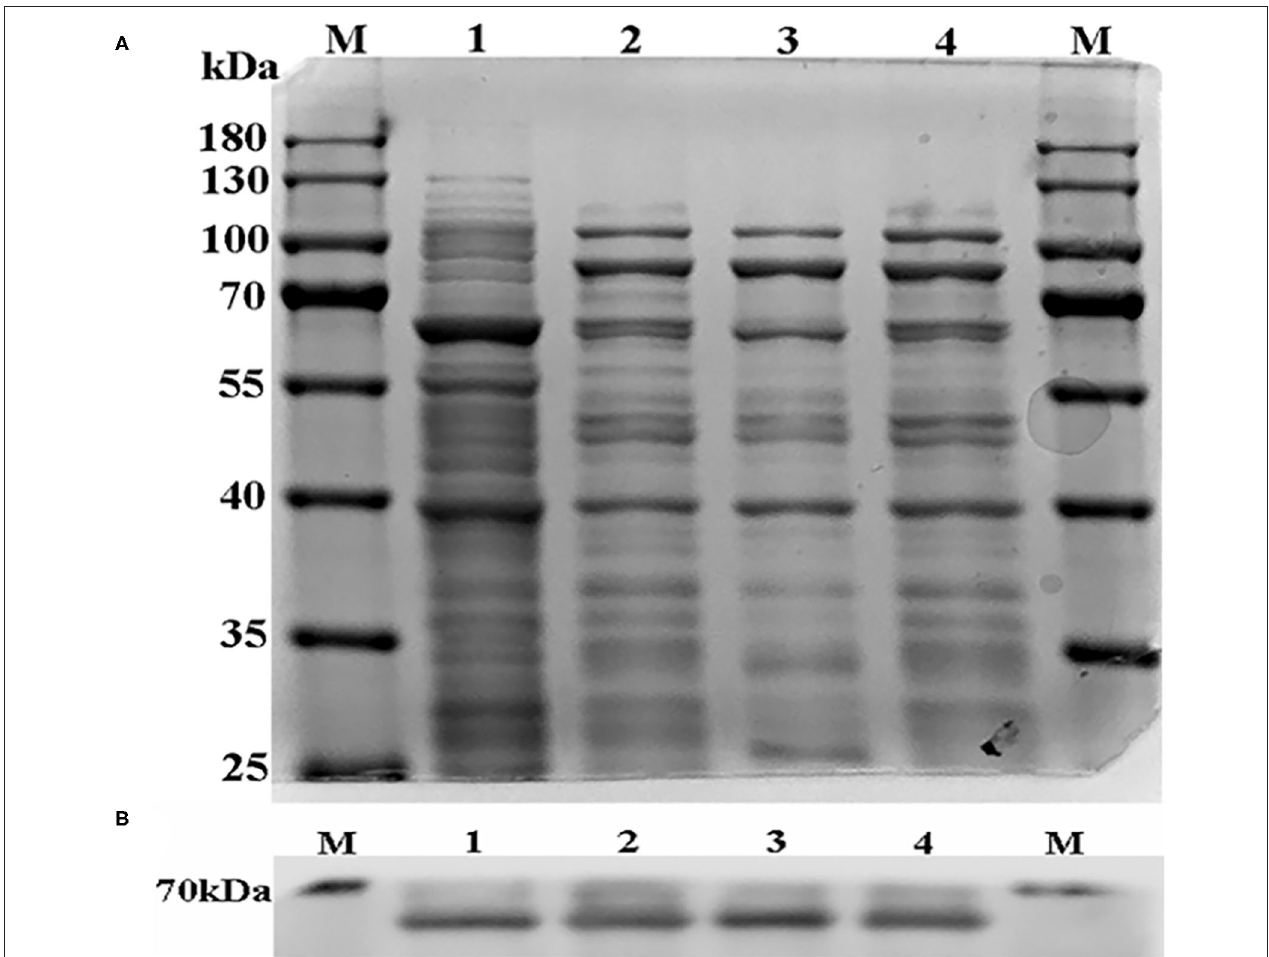
FIGURE 4 | The SDS-PAGE result of CYP3A24 and its mutants (A) . The Western blot result of CYP3A24 and its mutants (B) . (A) The sample volume in each line was 20 µ L, and no protein quantization was carried out. (B) The sample of each protein was 30 µ 4g. Line M is protein marker, lines 1–4 are CYP3A24, R105A, R372A, R440A,